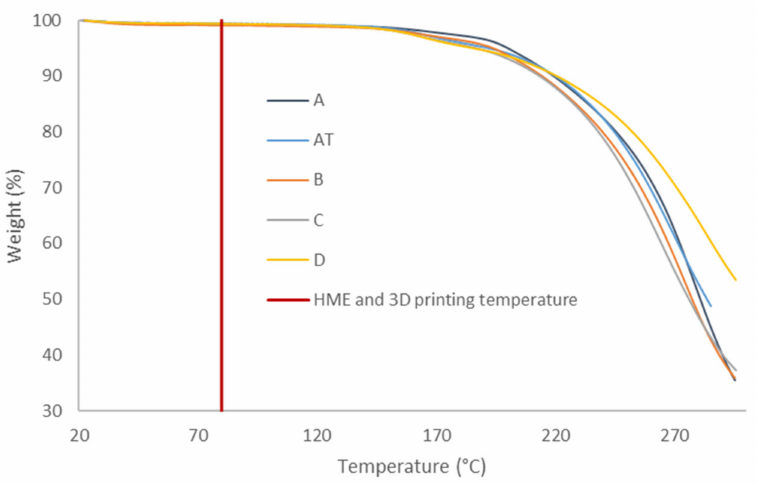
Figure 7. TGA thermal decomposition profile of formulations A, A T , B, C and D in state of pow- ders [41].